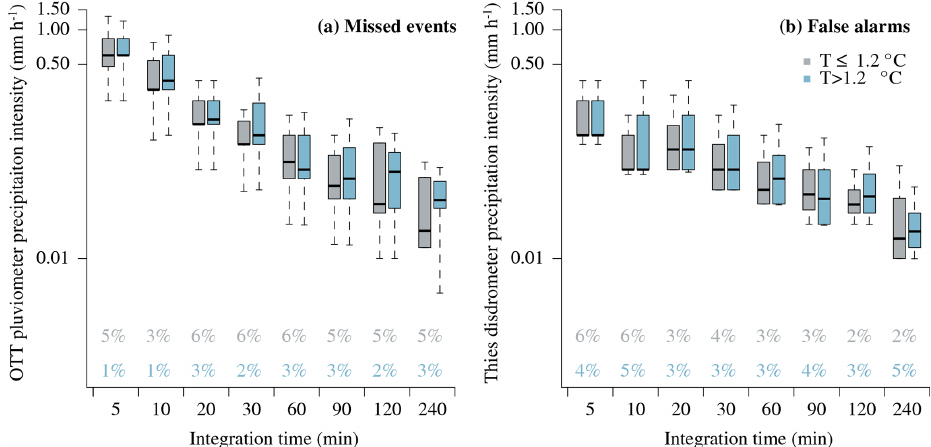
Figure 5. Distribution of precipitation intensities and phase during missed events (a) and false alarms (b) by the Thies disdrometer during the validation period (each box shows the median and interquartile range of the distribution, while the whiskers extend to 1.5 times this range from the box or to the most extreme data point). While precipitation intensities measured by the OTT pluviometer are analyzed during missed events, precipitation intensities indicated by the Thies disdrometer are analyzed during false alarms. Events are separated according to a temperature threshold (1.2 ◦ C), and the relative frequency of missed events, as well as the false alarm rate, is given at the bottom of each panel for cases above and below this temperature threshold. Note that a logarithmic scale is used to display precipitation